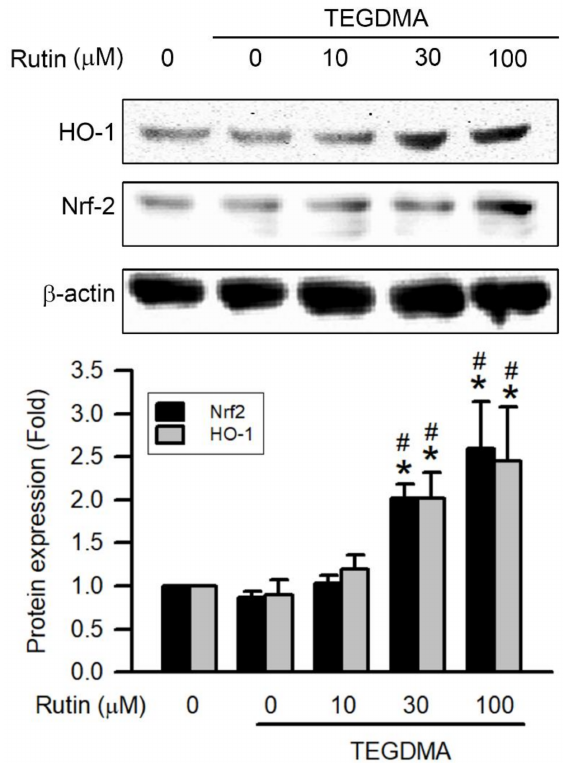
Figure 7. Effect of rutin on HO-1 and Nrf-2 expression in TEGDMA-treated RAW264.7 macrophages. Expression of HO-1 and Nrf-2 was determined using Western blotting with indicated